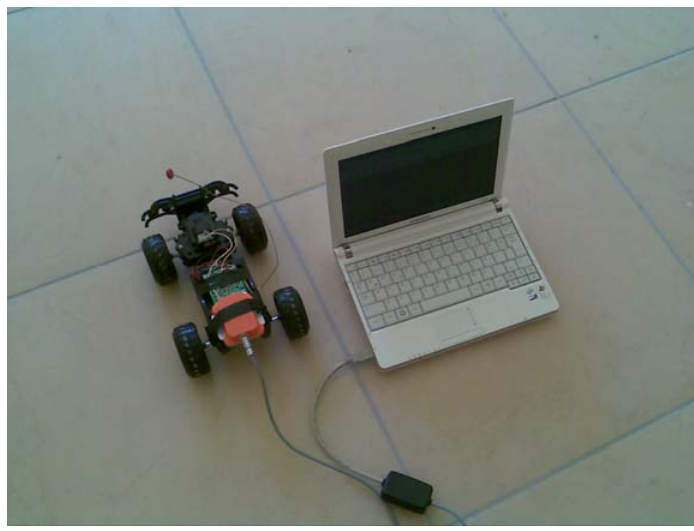
Figure 4. Experimental setup.